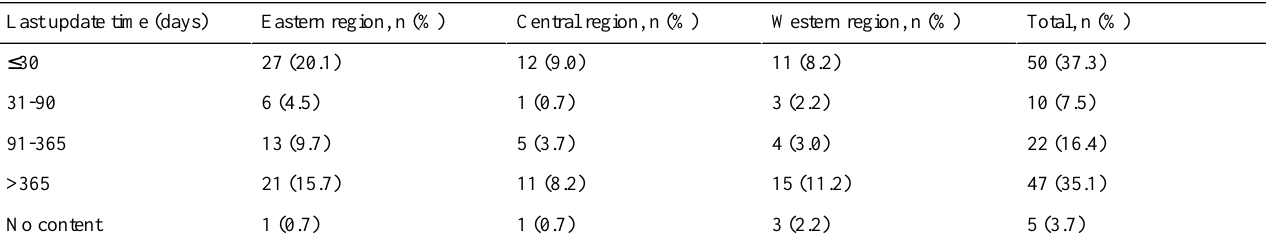
Table 2. The update time of the most recent Weibo tweets from the Center for Disease Control and Prevention’s government accounts (n=134).